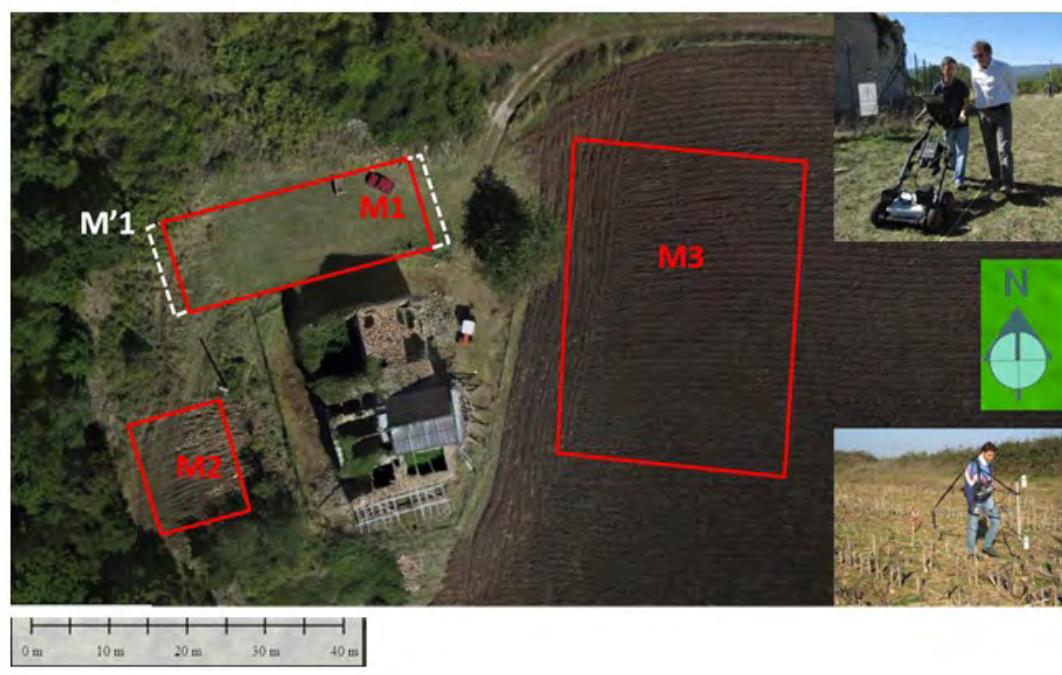
Figure 2. The areas investigated by GPR (M’1) and magnetometry (M1, M2 and M3). Upper right and lower right: images of georadar and magnetic data acquisition,